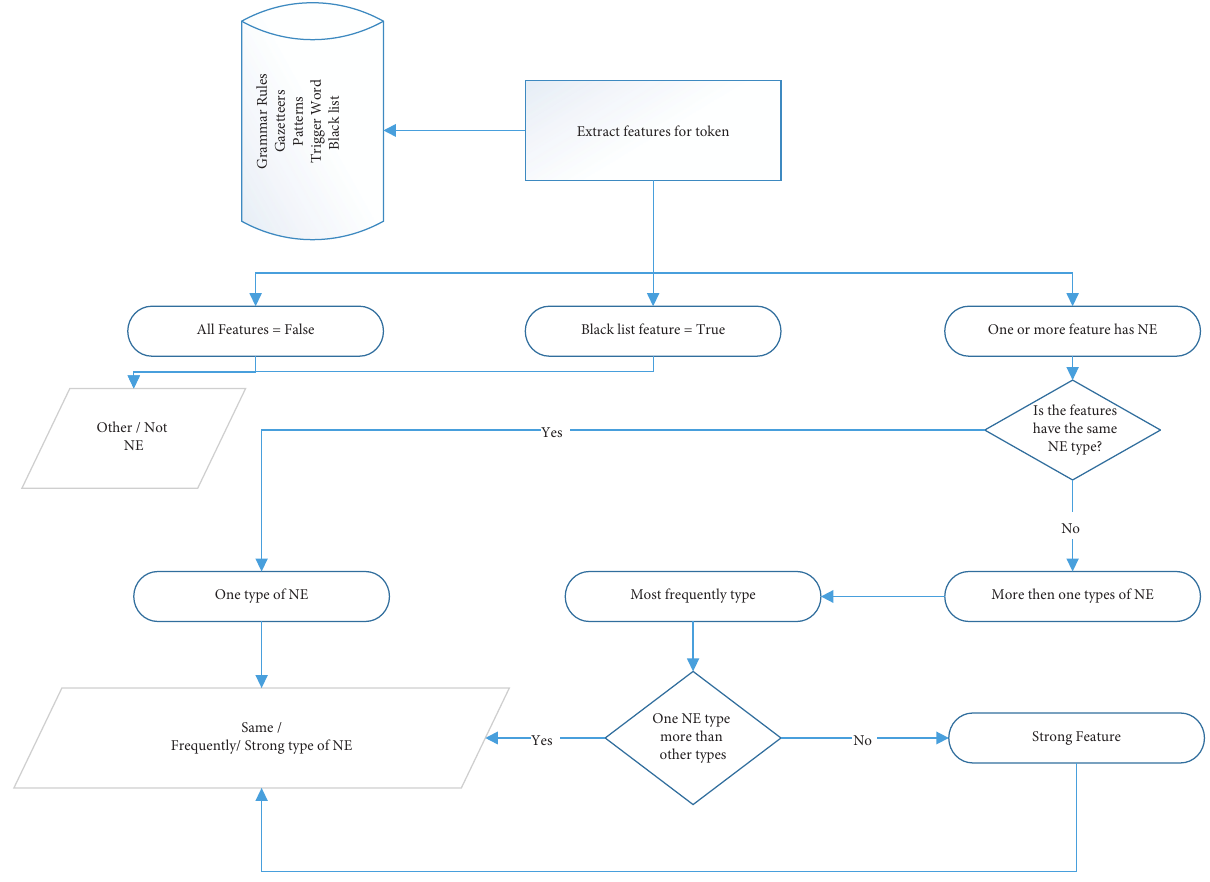
Figure 5: Operational stage for the proposed system. Table 11: Results of not using trigger